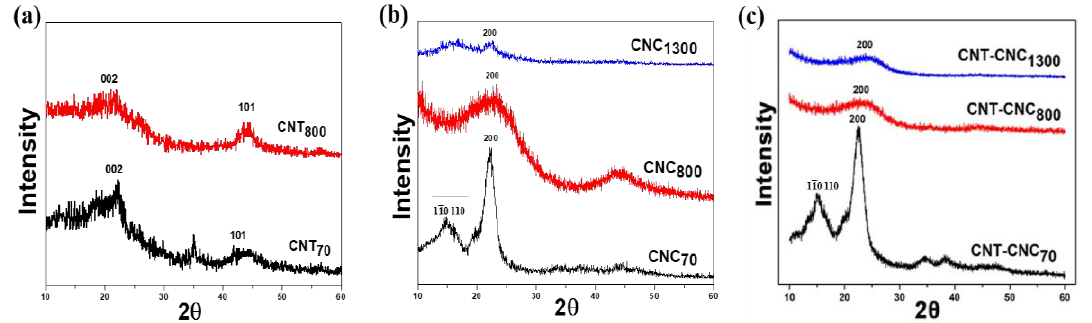
Figure 3. X-ray di ff raction (XRD) pattern of ( a ) CNT at 70 ◦ C and 800 ◦ C, ( b ) CNC at 70 ◦ C, 800 ◦ C, and Figure 3. X-ray diffraction (XRD) pattern of ( a ) CNT at 70 °C and 800 °C, ( b ) CNC at 70 °C, 800 °C, 1300 ◦ C, and ( c ) CNT–CNCs at 70 ◦ C, 800 ◦ C, and 1300 ◦ and 1300 °C, and ( c ) CNT – CNCs at 70 °C, 800 °C, and 1300 °C.